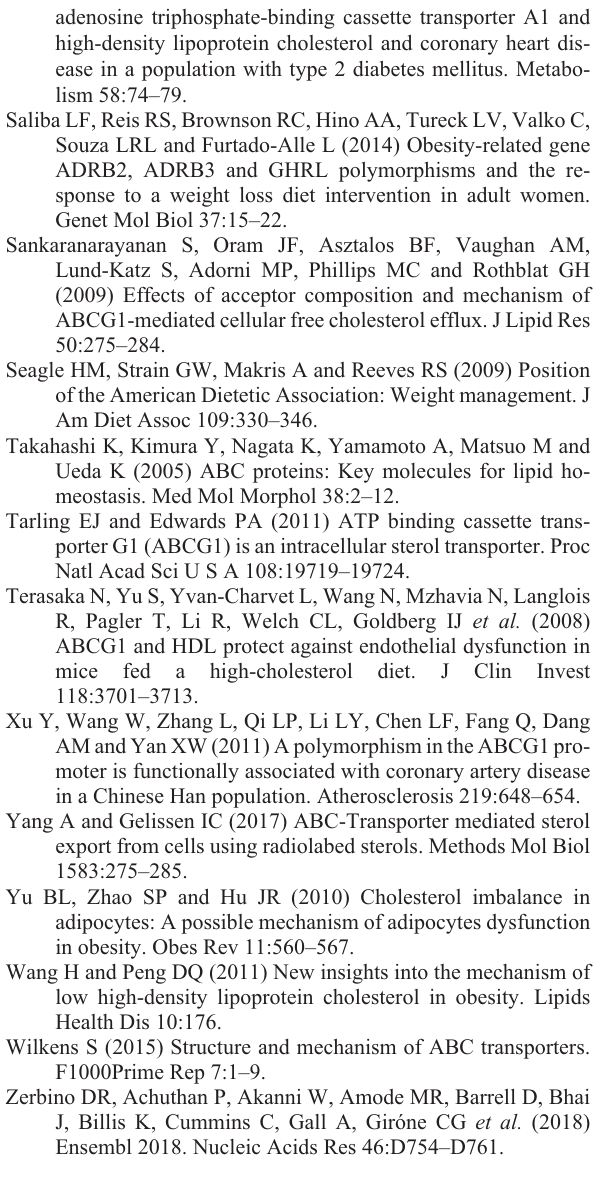
Figure S1 - Distributions of total cholesterol levels (A) at baseline and after diet and (B) the difference between these two moments in study